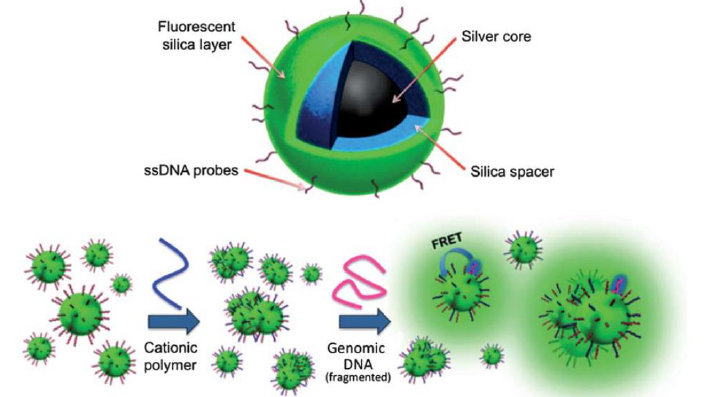
Figure 11. Nano-biosensor for DNA detection. Top: multi-layer core – shell nanoparticles (NPs) are made of an Ag core (35 nm) separated from an outer fluorescent silica layer by a spacer also made of silica of a few nanometers in thickness. The outer silica surface is functionalized with oligonucleotide capture probes. Bottom: schematic description of the proposed detection scheme: (1) “target-ready” nano-biosensor is prepared by mixing the cationic polymer transducer with probe-grafted NPs, and surface-charge-neutralization promotes formation of nanoparticle aggregates; (2) upon mixing the nano-biosensor with target DNA, hybridization with oligonucleotide probes occurs, which activates the polymer transducer and amplifies the optical signal via energy transfer to the fluorescent NPs. Reprinted with permission from ref. [90]. Copyright 2013, RSC.